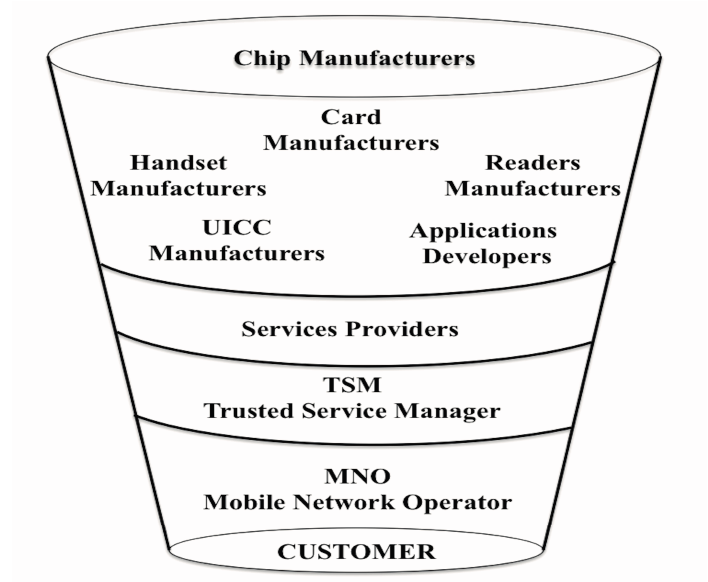
Figure 1. Near Field Communication stakeholder ecosystem (source: authors’ elaboration based on